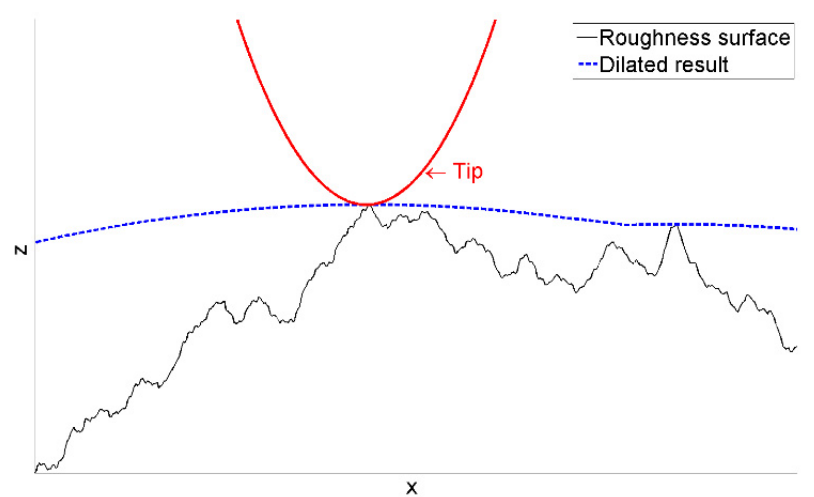
Figure 3. Schematic diagram of tip dilation on a rough surface.